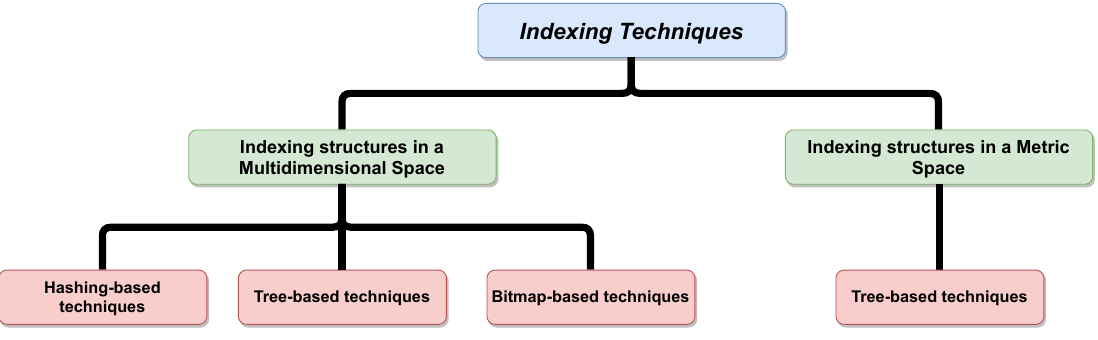
Figure 6. Global taxonomy of indexing